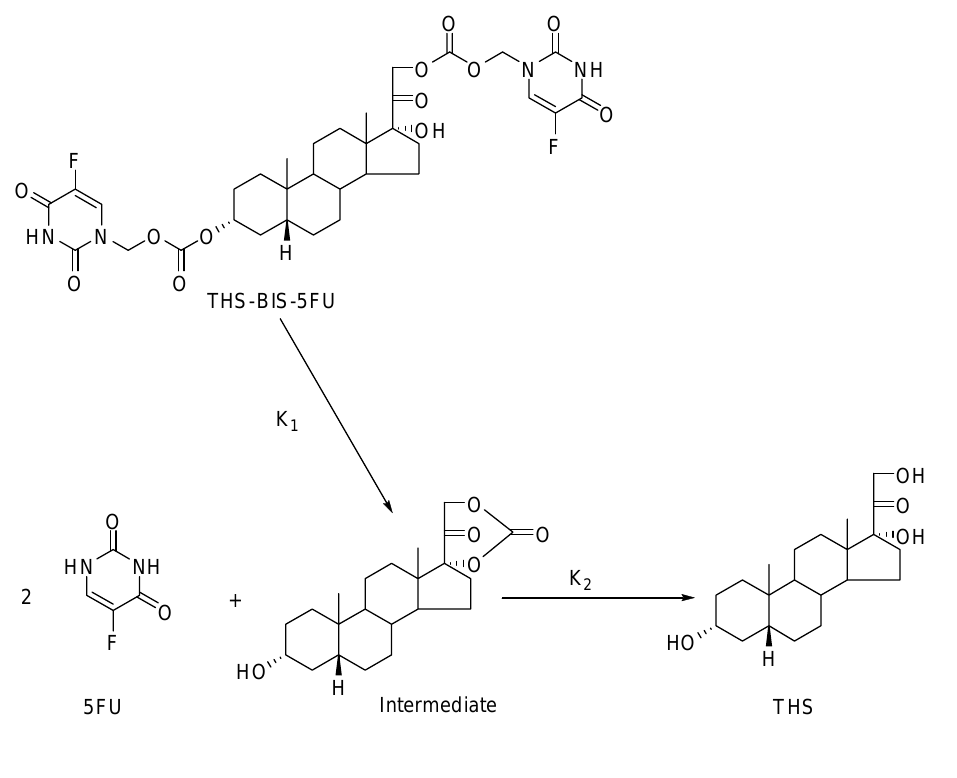
Figure 3. The THS-BIS-5FU codrug and the hydrolytic pathway for the release of THS and 5FU.